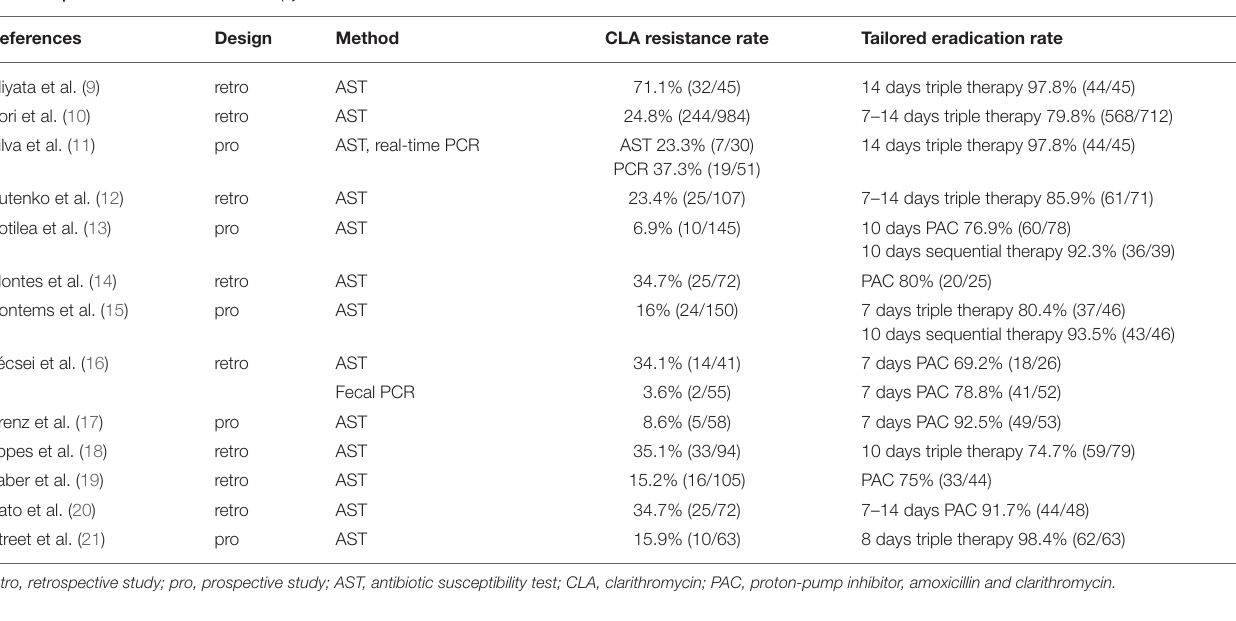
TABLE 1 | Researches of tailored therapy in children.